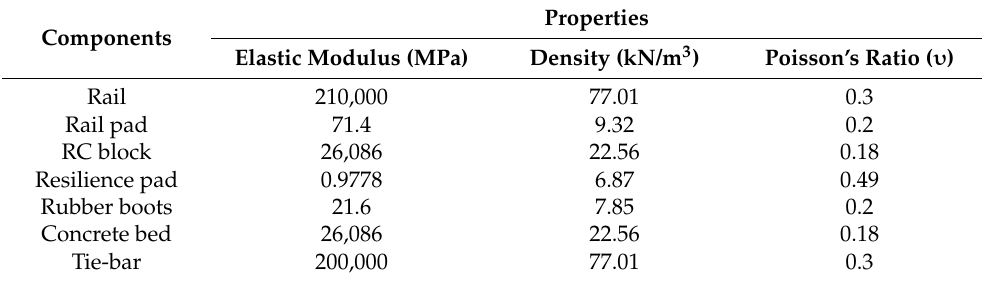
Table 1. Material properties of booted sleeper track (STEDEF) system